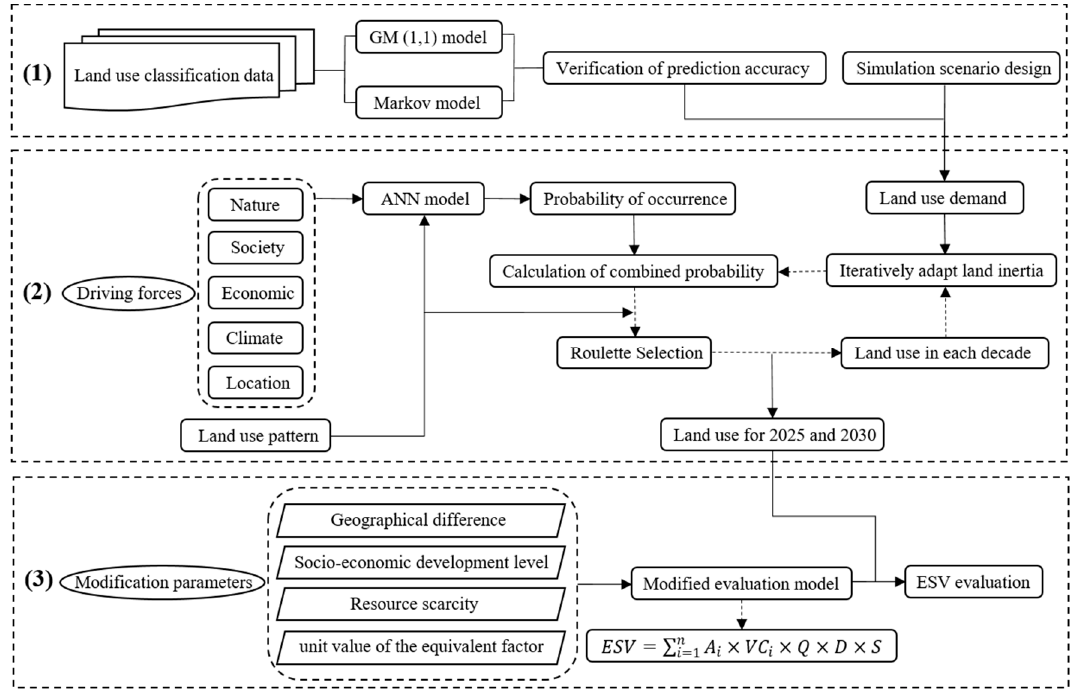
Figure 2. The framework of this study: ( 1 ) prediction of land use structure; ( 2 ) Land use layout simulation using FLUS model; ( 3 ) ESV estimation using the revised model.